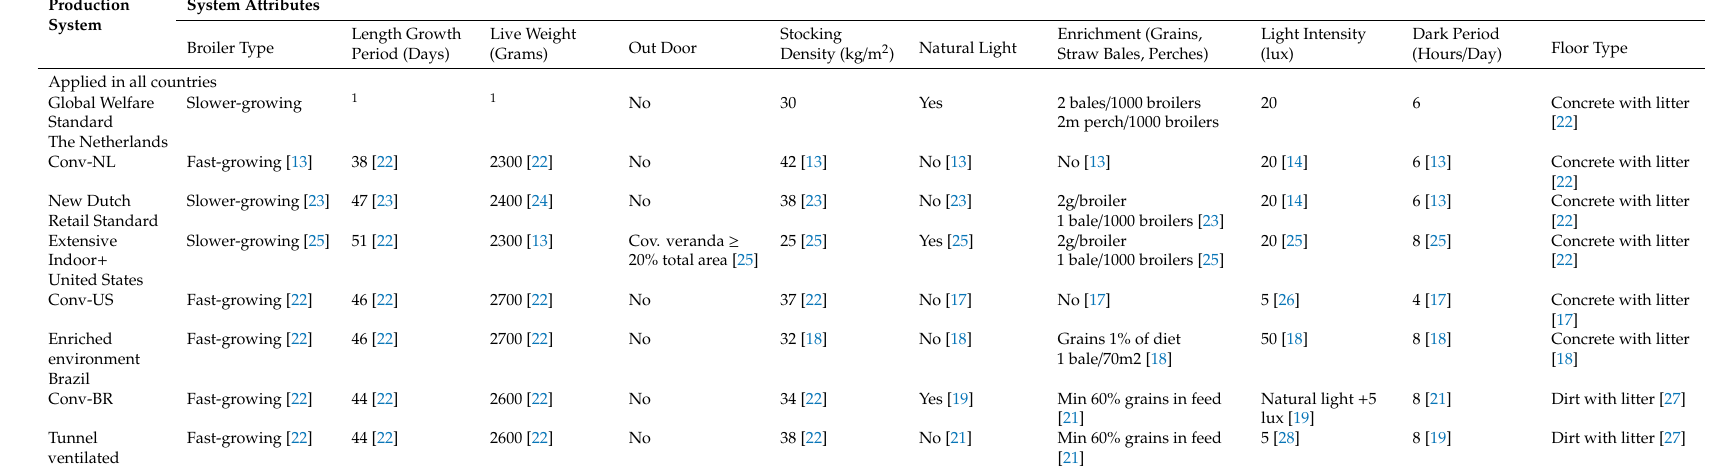
Table 1. Overview of the system attributes of the broiler production